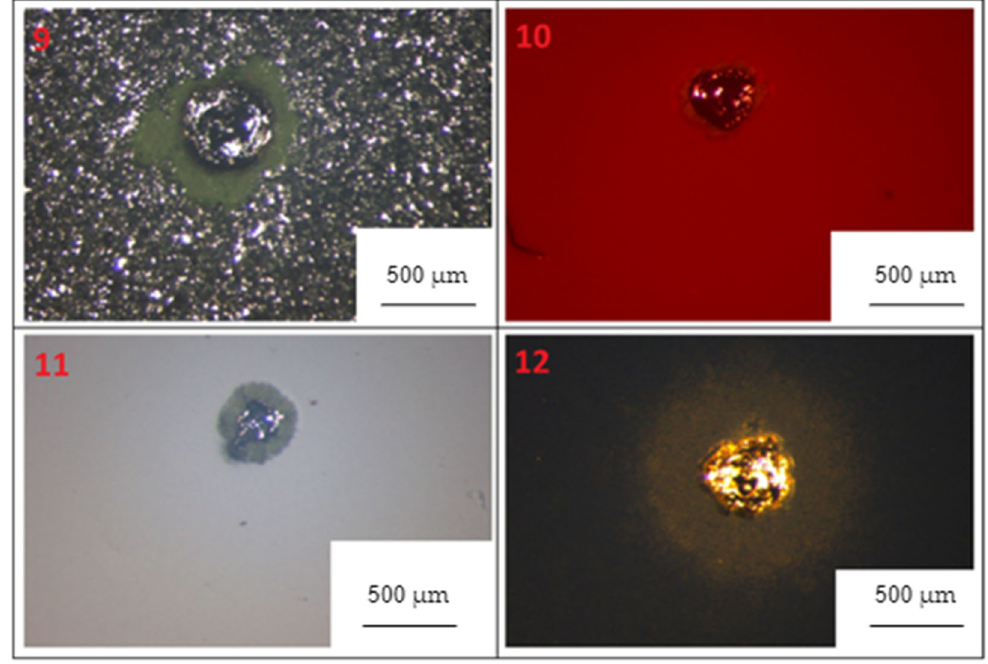
Figure 8. Damages of samples by electric discharge 9–12 (sorted following Table